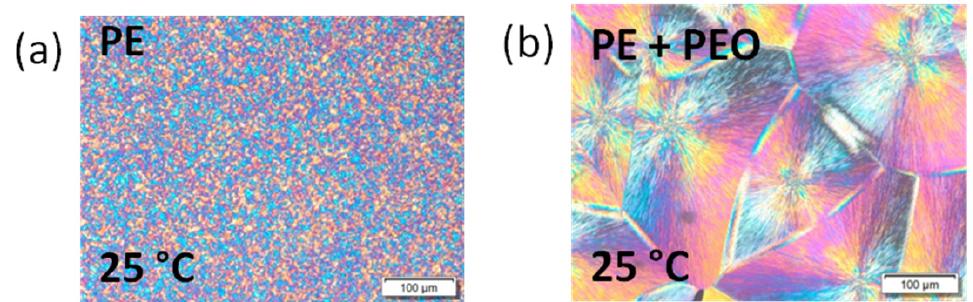
Figure 9. PLOM micrographs taken at room temperature after cooling from the melt at 20 °C/min for ( a ) PE 7.1 and ( b ) PE 327.1 -b- PEO 6815.1 , indicating the crystalline phases at 25 °C.